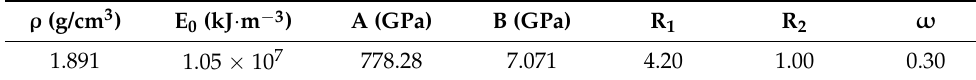
Table 1. The parameters in the JWL EOS of